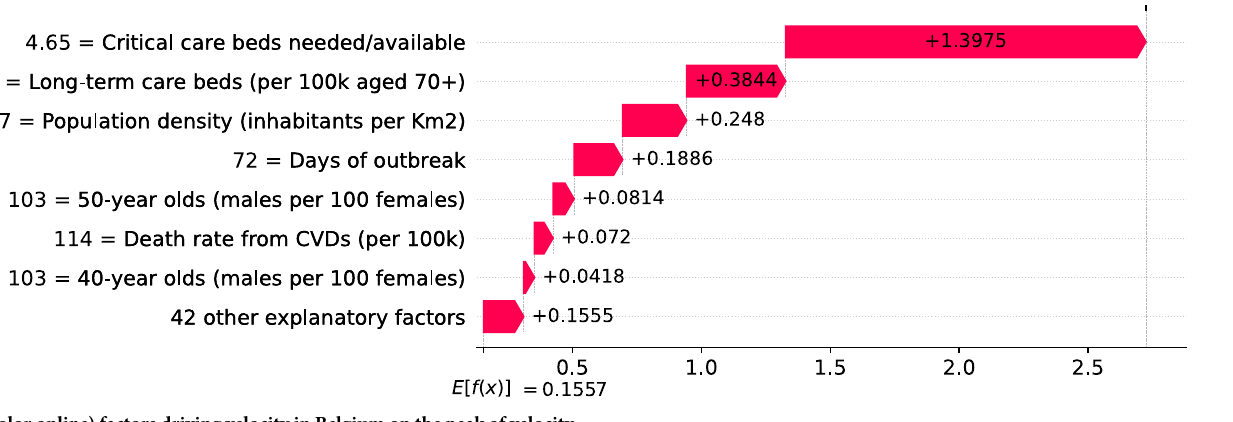
Fig 33. (Color online) factors driving velocity in Belgium on the peak of velocity.